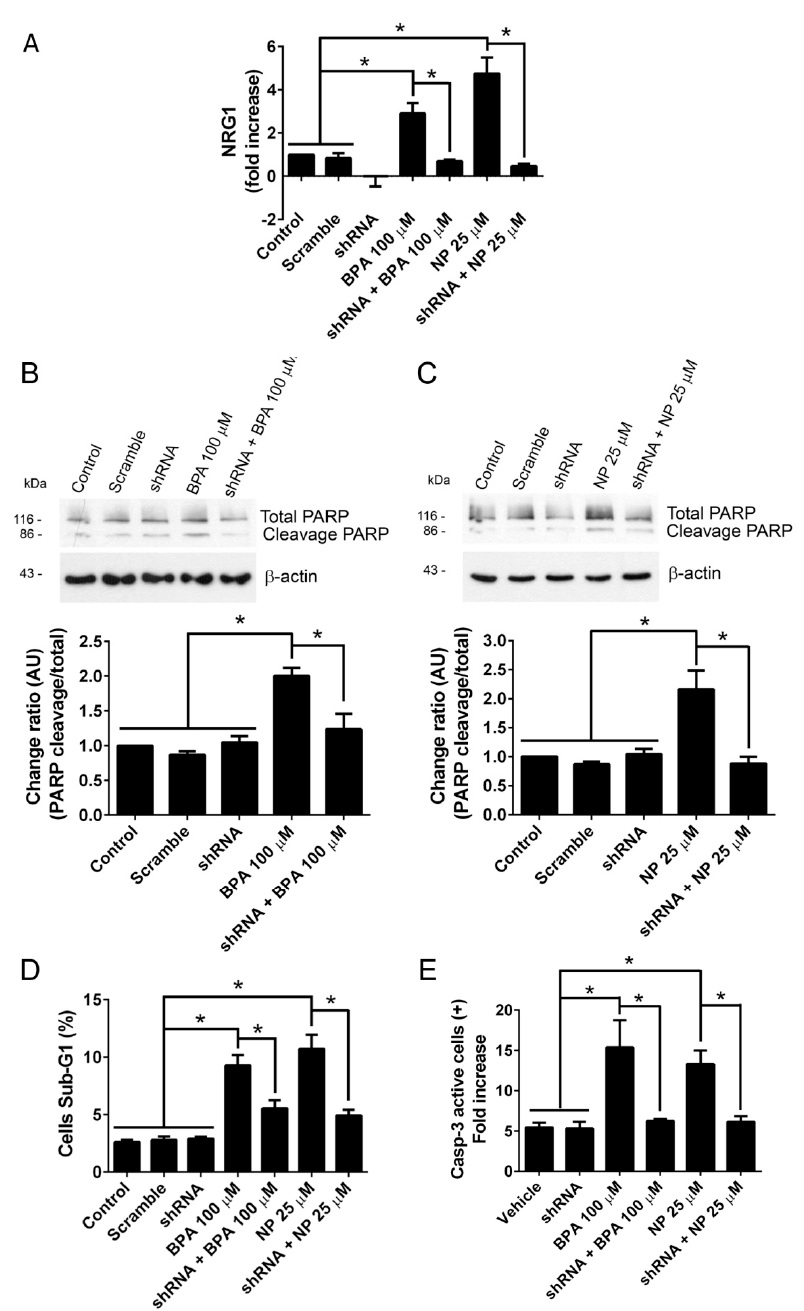
Figure 4. Silencing of ADAM17 prevents NRG1 shedding and apoptosis induced by BPA or NP in A2780 cells. ( A ) Shedding of NRG1 significantly increases in A2780 cells transfected with (AP)-NRG1 vector when they are incubated for 2 h in the presence of 100 µ M BPA or 25 µ M NP. This effect is prevented when ADAM17 is silenced by the use of 10 µ g shRNA. Treatment with 100 µ M BPA ( B ) or 25 µ M NP ( C ) for 2 h induces a significant increase in the cleaved form (86 kDa) of PARP detected by Western blot, which was prevented when ADAM17 was silenced with 10 µ g shRNA. Treatment with 100 µ M BPA or 25 µ M NP for 2 h induces a significant increase in the sub-G1 population ( D ) and cleaved caspase-3-positive cells of A2780 cells line ( E ), which were prevented when ADAM17 was knocked down with 10 µ g shRNA. Mean ± SEM, * p < 0.05, n =